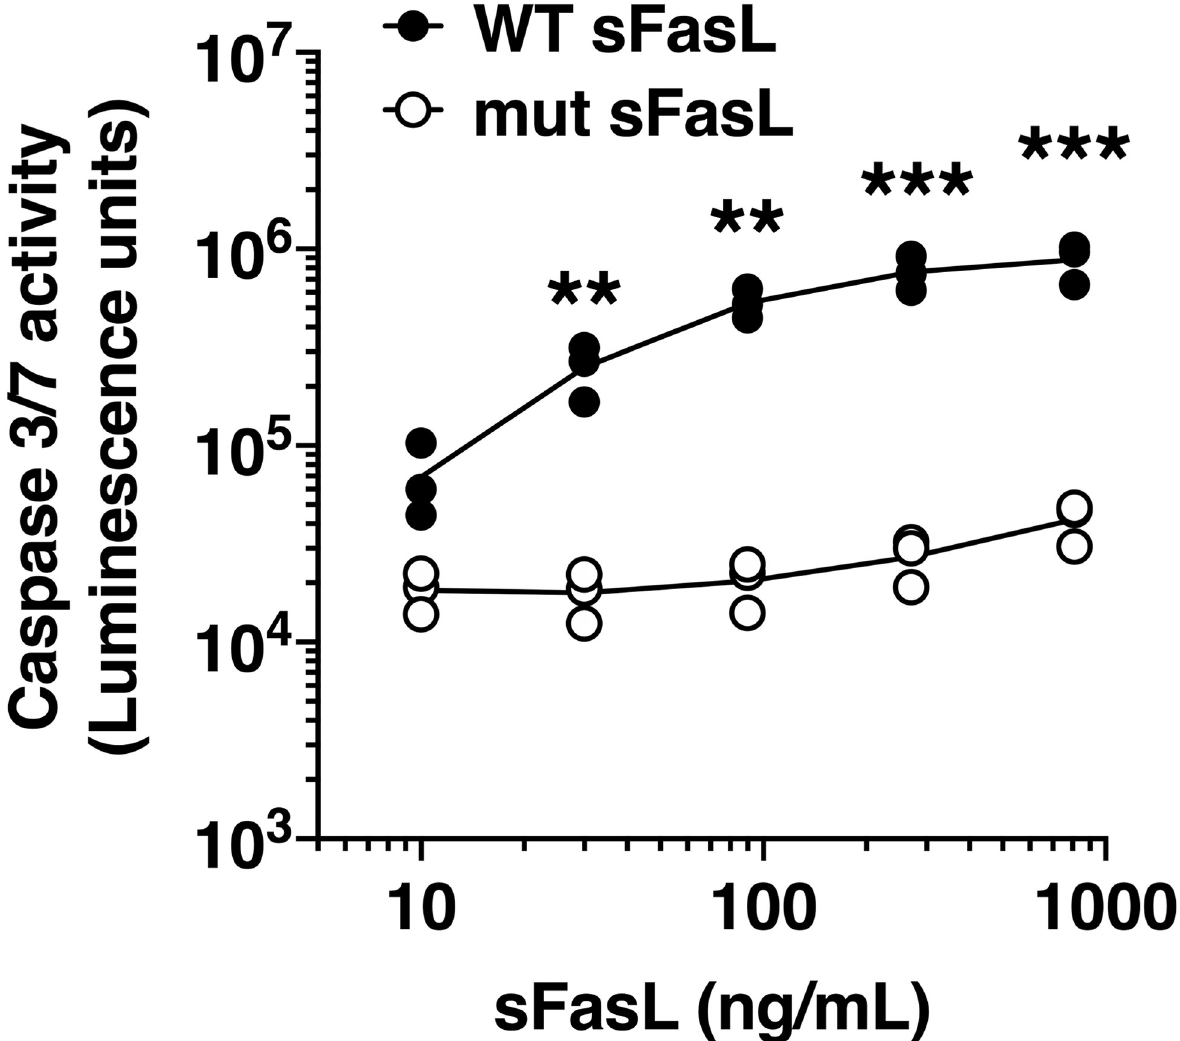
Fig 2. Bioactivity of the sFasL mutant protein. Jurkat cells were incubated for 5 hours with wild type (WT) sFasL or a sFasL mutant (mut sFasL) in which all of the 8 charged amino acids were changed to alanine. Caspase 3/7 activity was measured after incubation with the caspase 3/7 substrate at room temperature for 30 minutes. Data are shown as arbitrary luminescence units. Results show data from three separate experiments, each performed in duplicate. Each dot represents individual data. Data analyzed by 2-way ANOVA with Sidak post-hoc analysis. �� p < 0.01, ��� p < 0.001 compared with the respective concentration of